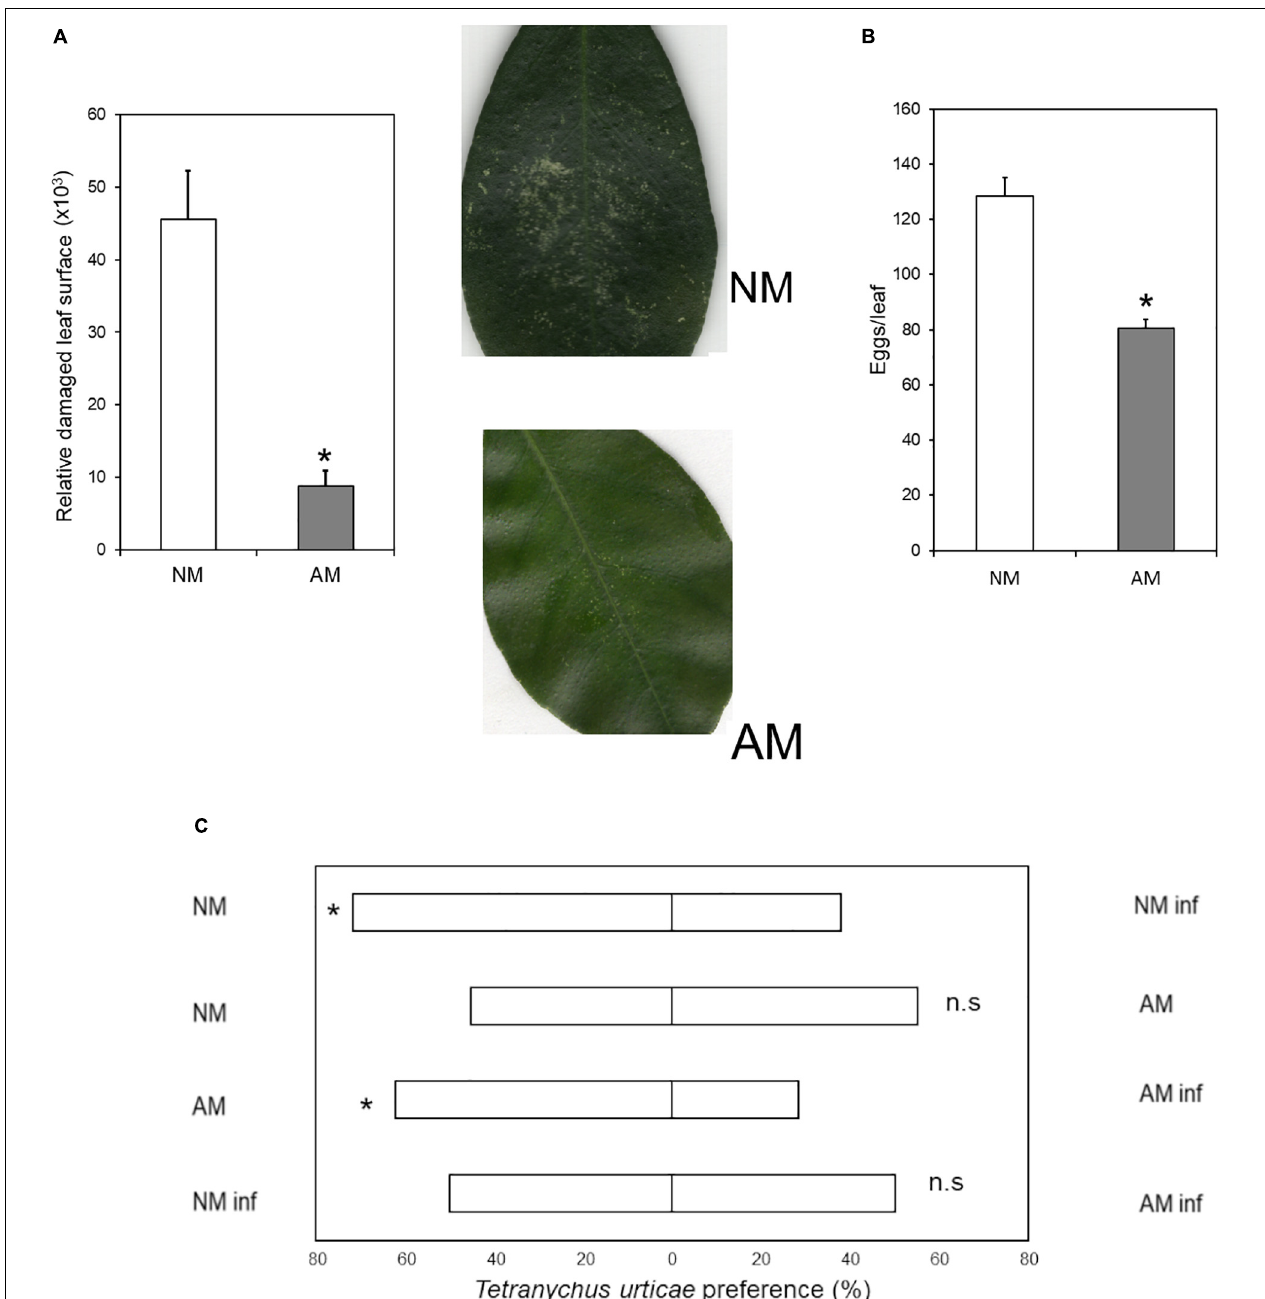
FIGURE 1 | Antibiosis and antixenosis of C. aurantium NM and AM plants upon T. urticae infestation. (A) Relative leaf damaged area: Three-months-old plants were infested with 5 mites per leaf (two leaves per plant). Asterisks indicate significant differences between treatments ( P < 0.05; t -test; n = 6). Pictures show an example of the damage. (B) Oviposition in mycorrhizal and non-mycorrhizal C. aurantium plants: 3-month-old C. aurantium plants were infested with 2-days-old T. urticae females (5 females per leaf, two leaves per plant). The number of eggs was determined 3 days after infestation. Different letters indicate significant differences between treatments ( P < 0.05; t -test; n = 6). (C) Antixenotic effects on T. urticae performance when exposed to odors of mycorrhizal or non-mycorrhizal plants or plants previously infested with conspecifics. Four different assays were carried out where mites had to choose between plant odors of two different treatments. A minimum of 4 plants and 45 spider mites were tested for each combination. Every assay was repeated a minimum of three times on different days. The different combinations performed, were as follows: First: non-mycorrhizal non-infested plants (NM) versus non-mycorrhizal infested plants (NM inf); second: non-mycorrhizal non-infested plants (NM) versus mycorrhizal non-infested plants (AM); third mycorrhizal non-infested plants (AM) versus mycorrhizal infested plants (AM inf) and fourth: non-mycorrhizal infested plants (NM inf) versus mycorrhizal infested plants (AM inf). Plants were randomly infested with 20 adult females 24 h before assays. Mites used to choose between combinations were starved 24 h before the assays. Asterisks indicate significant differences for a 50:50 distribution (binomial test; P < 0.05).